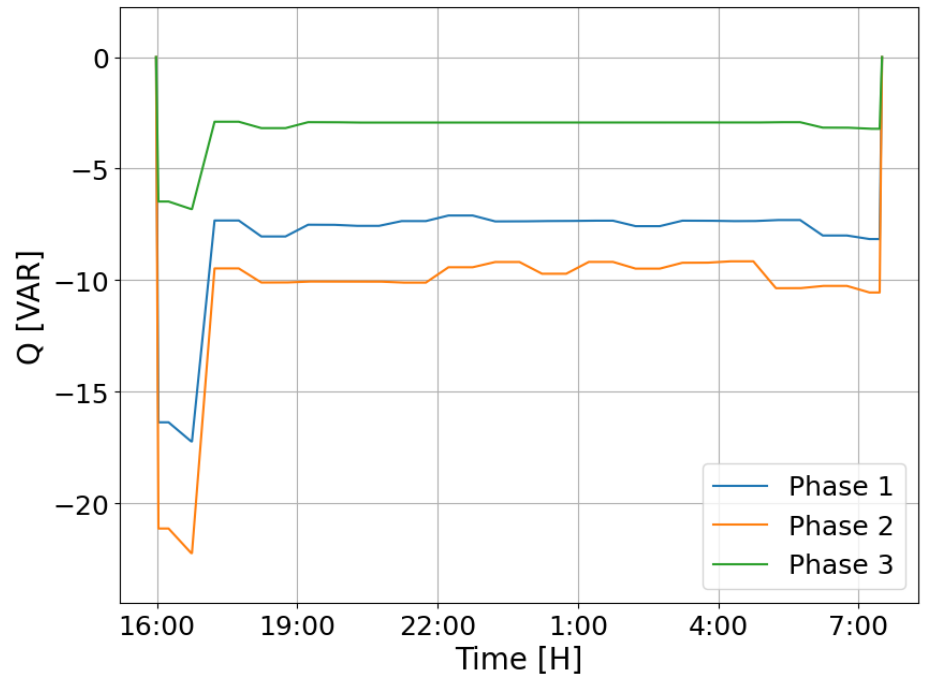
Figure 11. Characteristic of changes in reactive power values—luminaires with LED sources (without reduction). Source: own